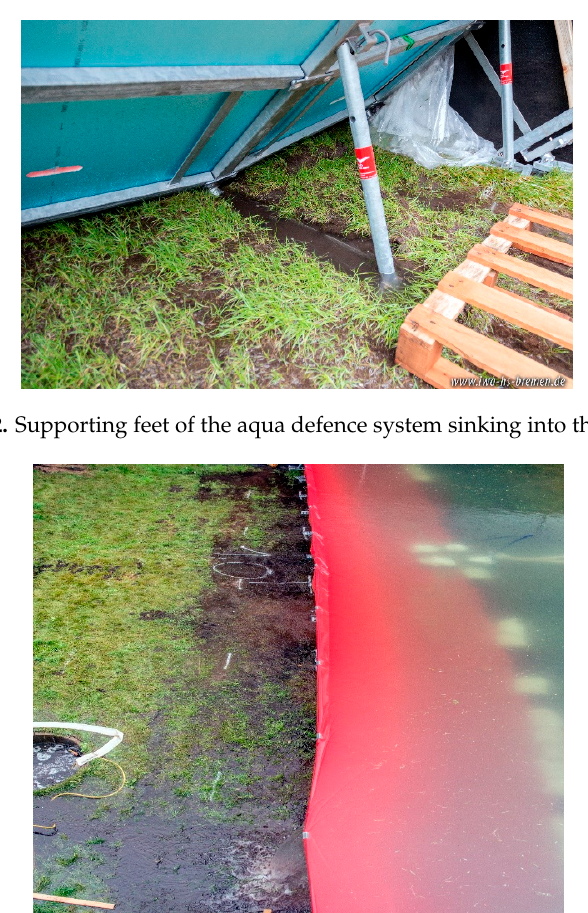
Figure 11. System dimensions, water heads according to manufacturers’ specifications, maximum water heads achieved during tests with location-independent mobile flood protection systems; the red line indicates recommended water heads according to BWK [20]. Geosciences 2018 , 8 , x FOR PEER REVIEW